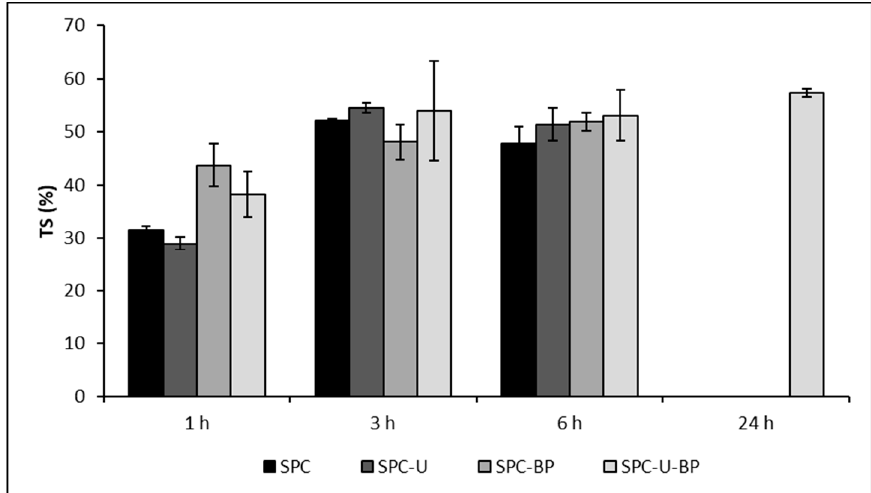
Figure 5. Thickness swelling (TS) of the injection-molded pieces after immersion in water.